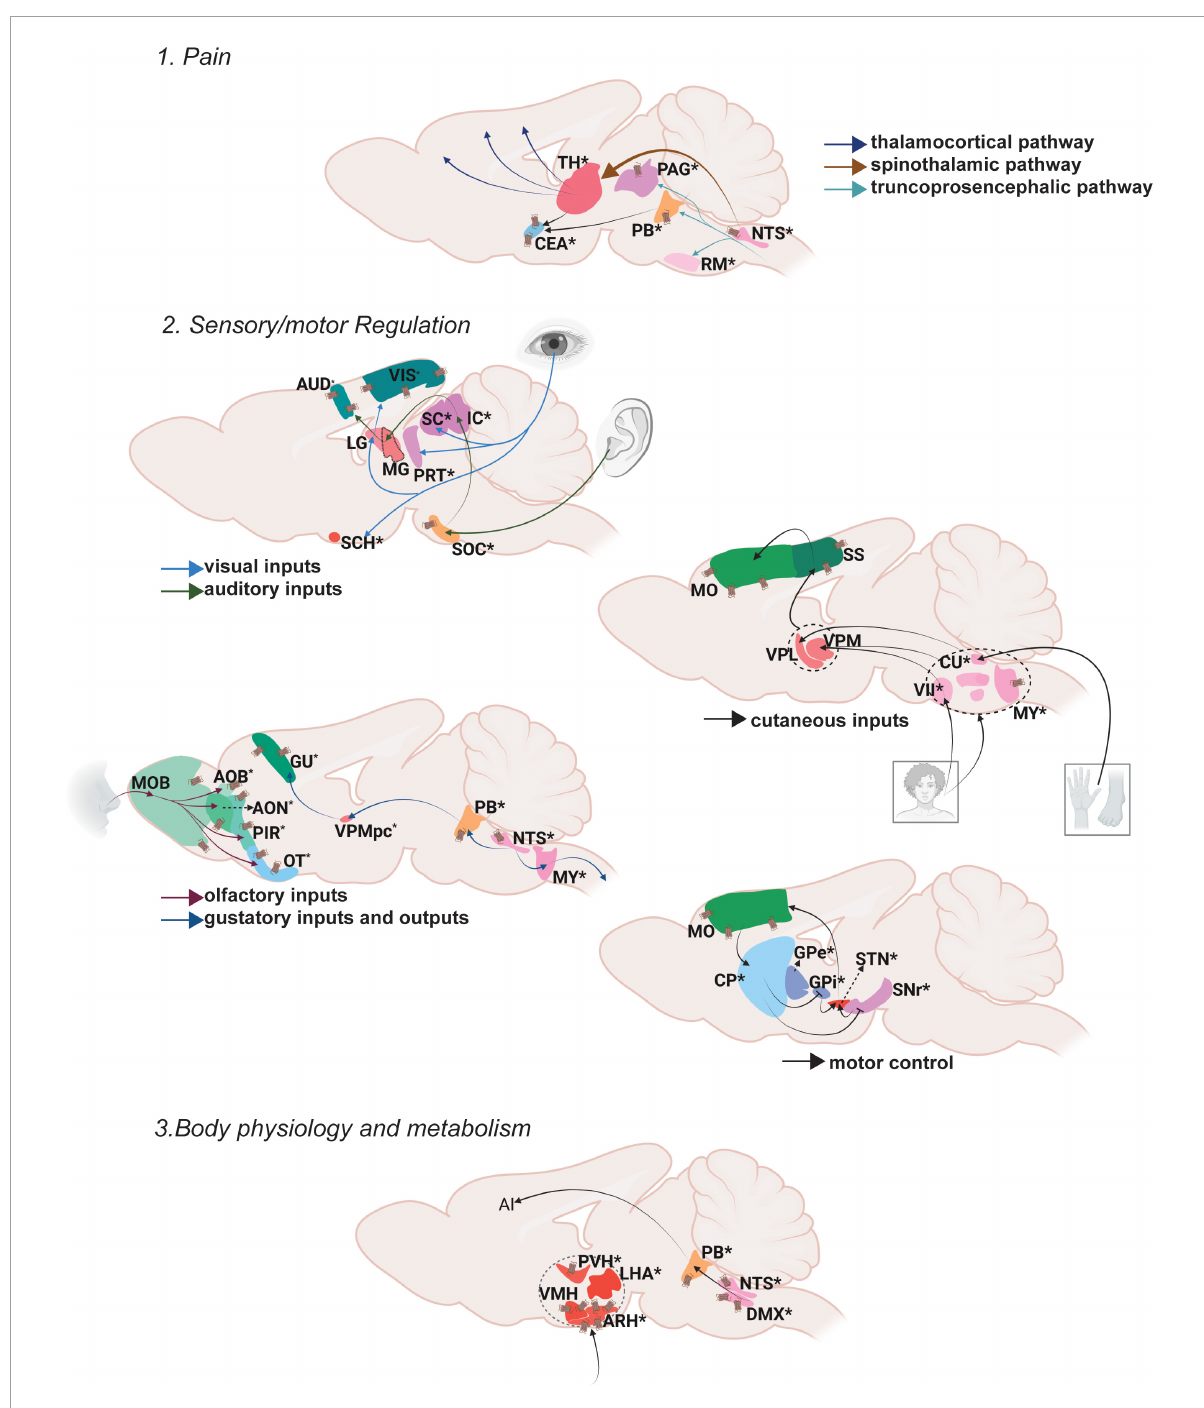
FIGURE2 Oxt regulation of somatic/visceral Control. Pathways depicting three different functional nodules.1. Pain, 2. Sensory/motor regulation, 3. Body physiology and metabolism. For further details refer, Figure 1 legend. For abbreviations, refer Table 1 .